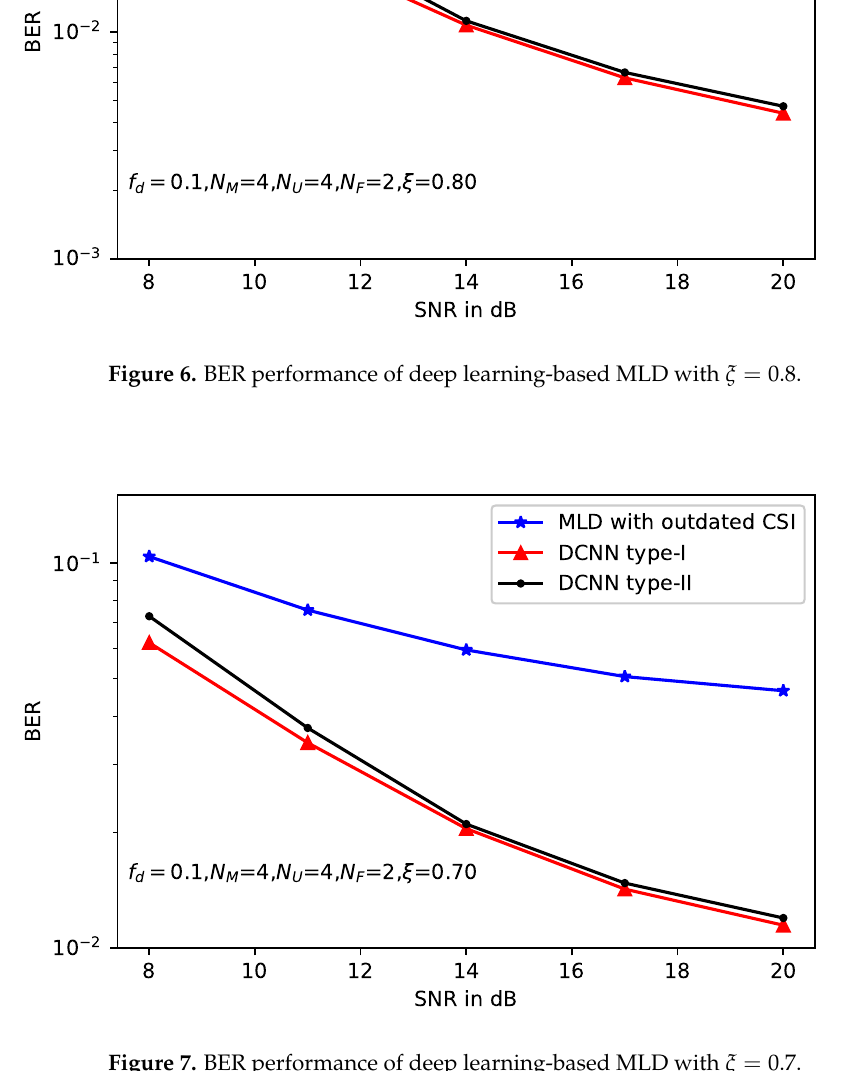
Figure 7. BER performance of deep learning-based MLD with ξ =